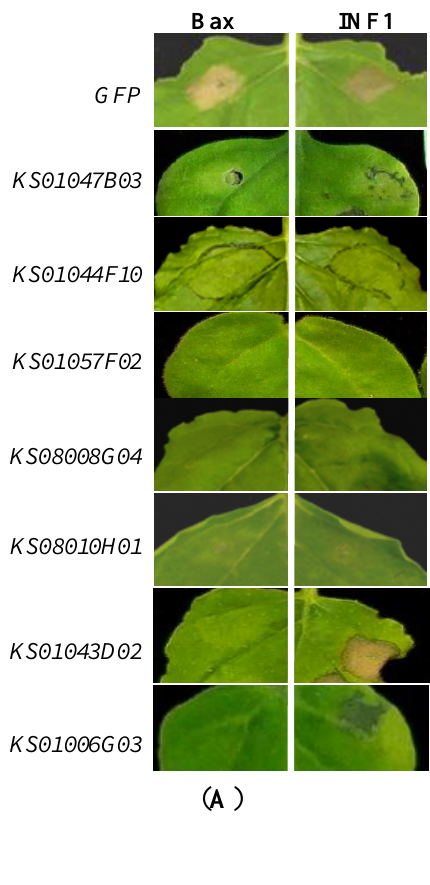
Figure 2. Cell death phenotypes in N. benthamiana after transient expression of Bax